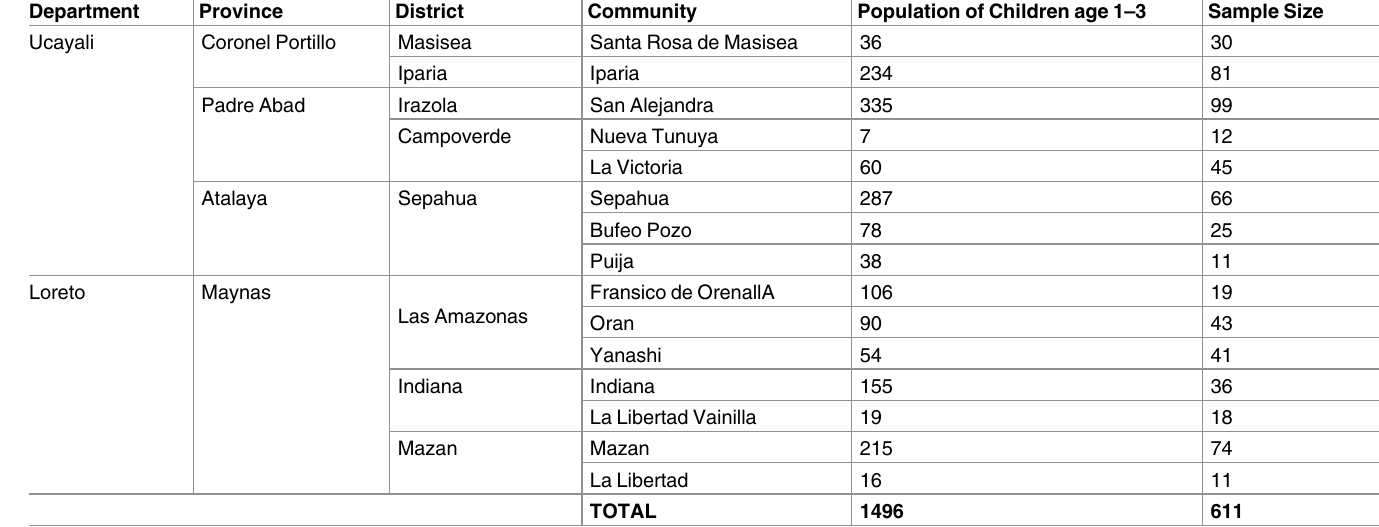
Table 1. Communities included in the study, population of children, and sample size obtained from each